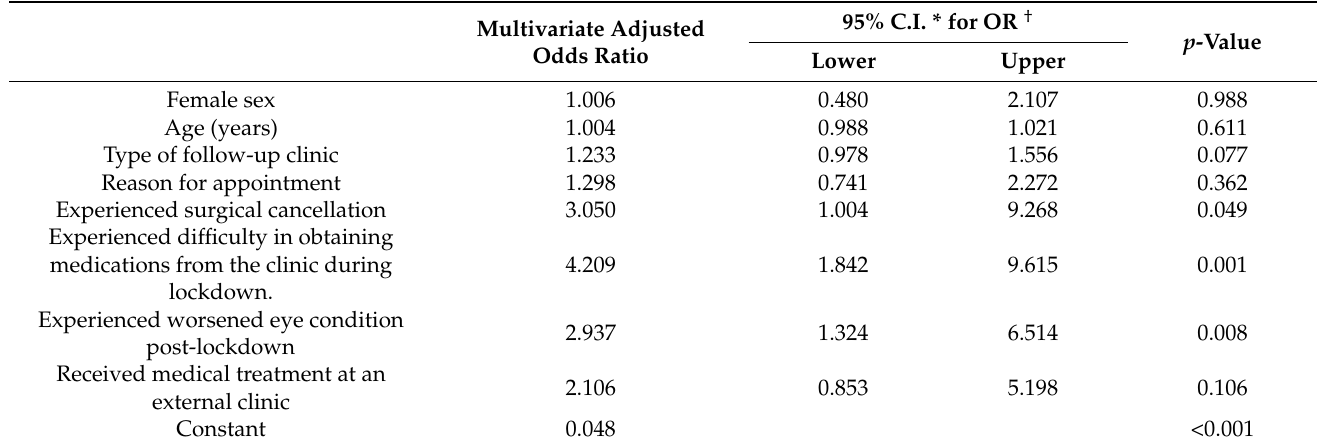
Table 4. Multivariate logistic binary regression analysis of the patients’ odds of dissatisfaction with clinical service during pandemic